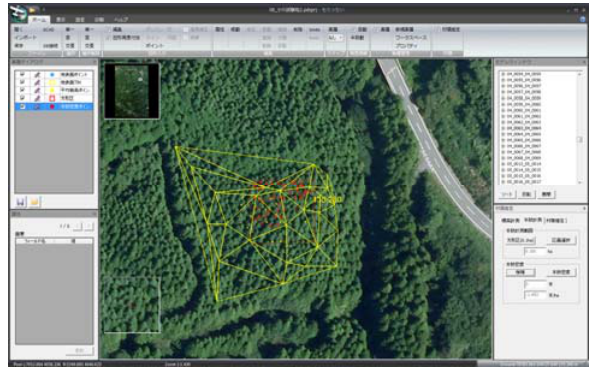
Figure 2. Calculation of timber